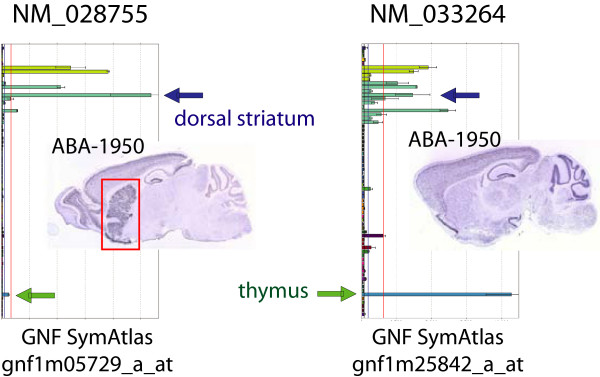
Spatial gene expression of the Arpp21 gene variants suggests only the isoform represented by RefSeq NM_028755 may be involved in the striatal cAMP signaling pathway. The striatum region is outlined by a red box. Brain images were obtained from the ABA database and the tissue gene expression data were obtained from GNF SymAtlas.